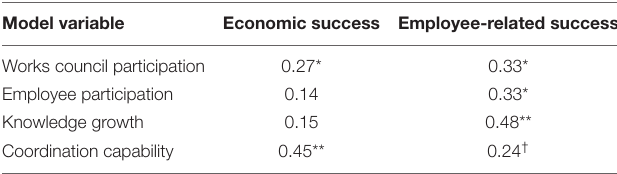
TABLE 5 | Correlations with subtypes of innovation success and their